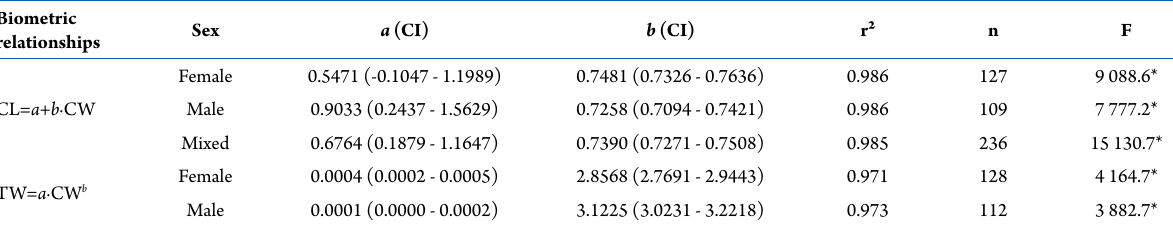
Table 1. Confidence intervals (0.95) for the parameters a and b from the biometric relationships of Hepatus pudibundus off Sergipe (northeastern Brazil) estimated for March/2015-May/2016.